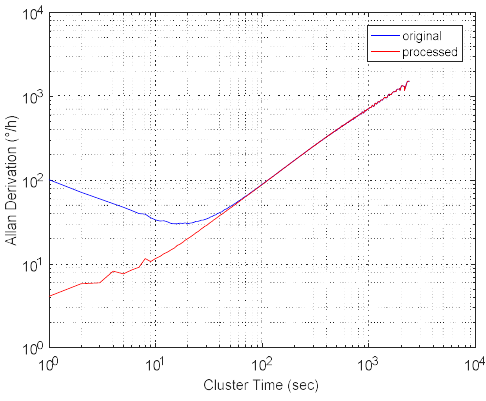
Figure 13. Allan variance analysis.